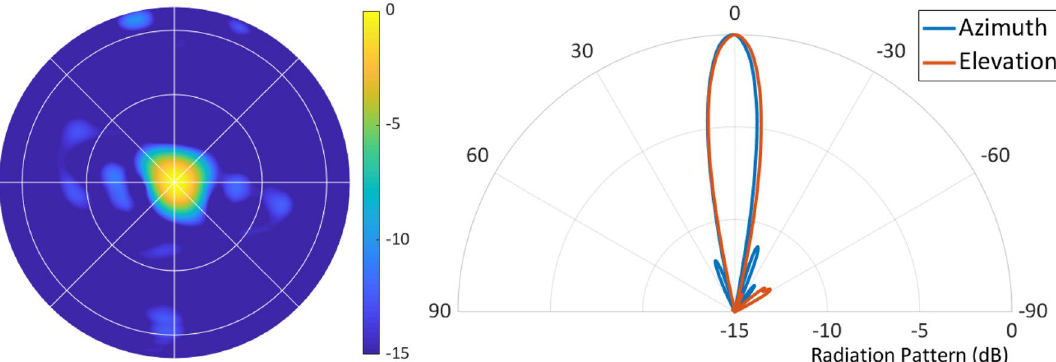
Figure 5. Broadside farfield radiation pattern (measured in normalized directivity) of the Nyquist metasurface antenna at 10 GHz. Farfields in all figures are in the u − v plane, where u = cos θ cos φ and v = cos θ sin φ , with gridlines showing θ at 30 ◦ and 60 ◦ and φ from 0 ◦ to 360 ◦ in 45 ◦ increments.